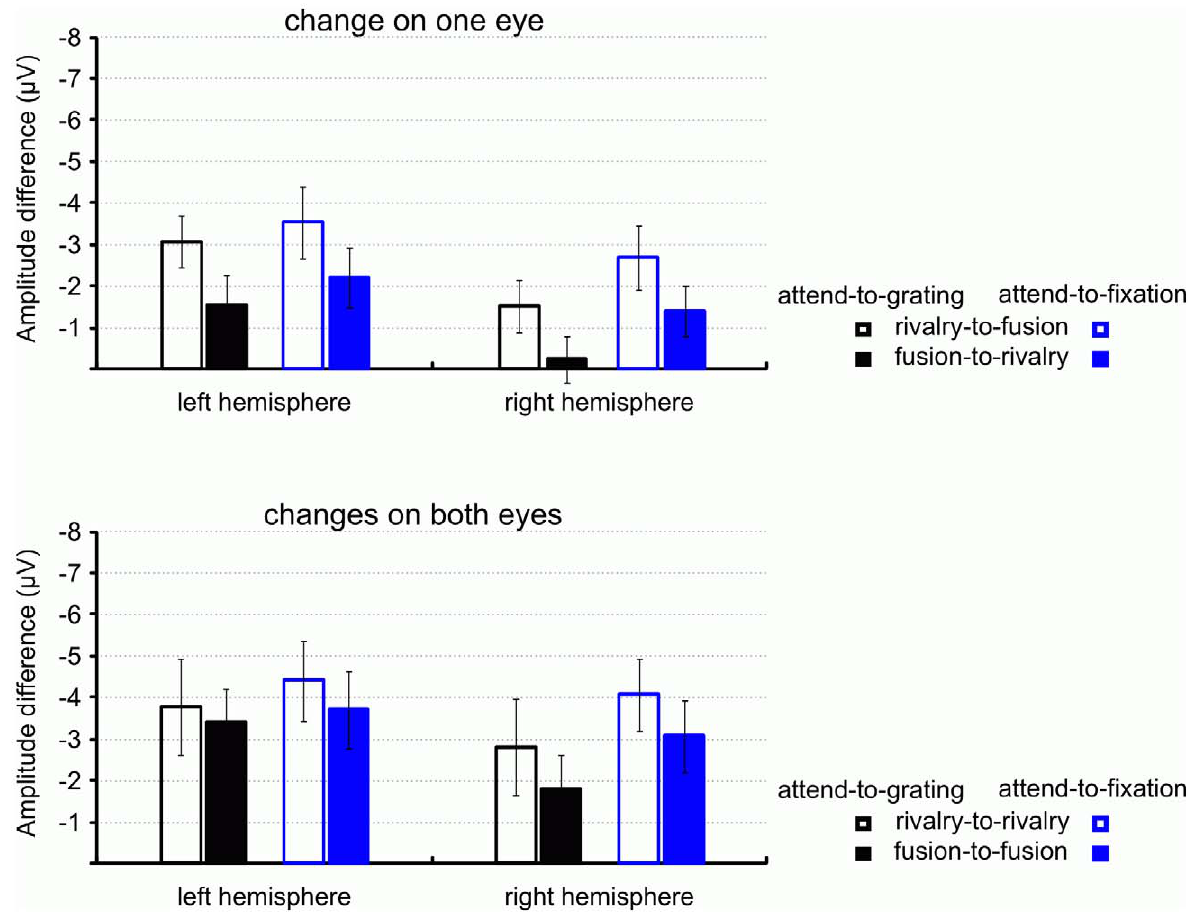
Figure 6. Bar graphs of the amplitude difference between N1 (160–210 ms) and post-N1 interval (210–300 ms) for transitions that involved an orientation change on only one eye (top) and transitions that involved orientation changes on both eyes (bottom) in the attend-to-grating (black) and the attend-to-fixation (blue) conditions. Changes from rivalry are depicted as unfilled bars; changes from fusion are depicted as filled bars.